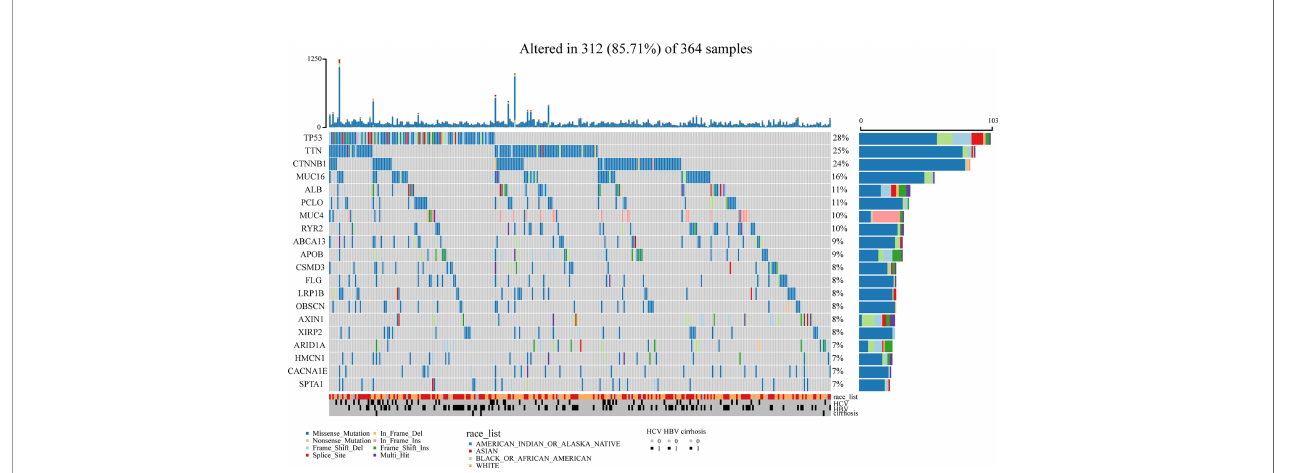
FIGURE 2 | Identi fi cation of mutated genes. The maftools package was used and we identi fi ed the top 20 highly mutated genes in LIHC. TP53 had the highest mutation frequency among